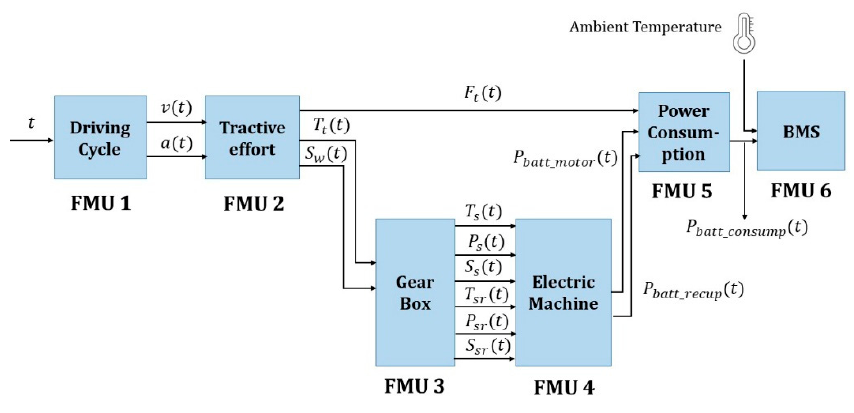
Figure 11. Functional mock-up interface-based electric vehicle co-simulation model.